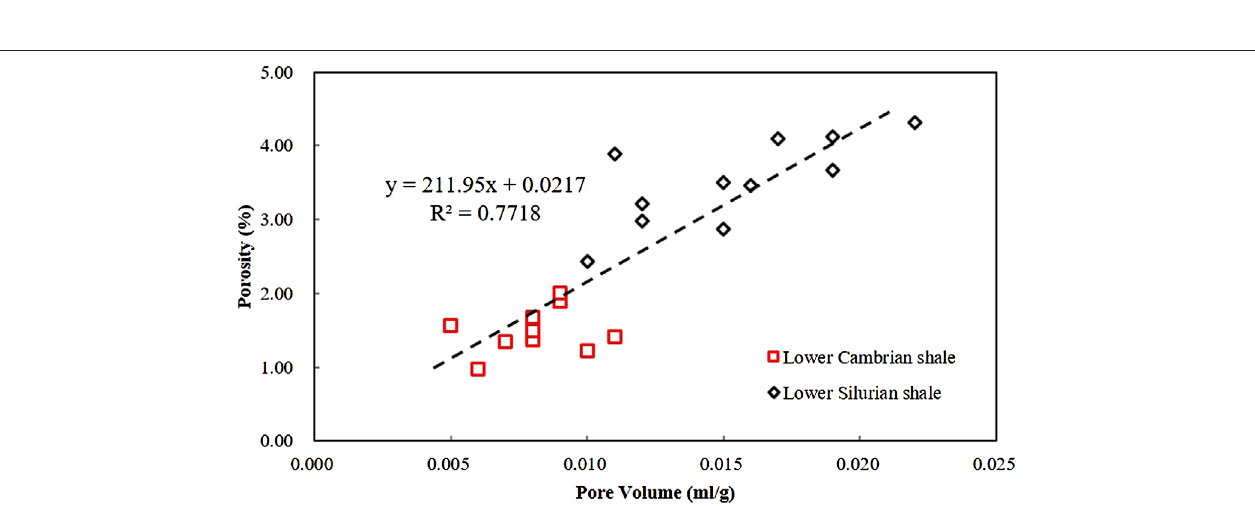
FIGURE 5 | Relationships between pore surface areas and pore diameters of the Lower Cambrian shales and Lower Silurian shales.